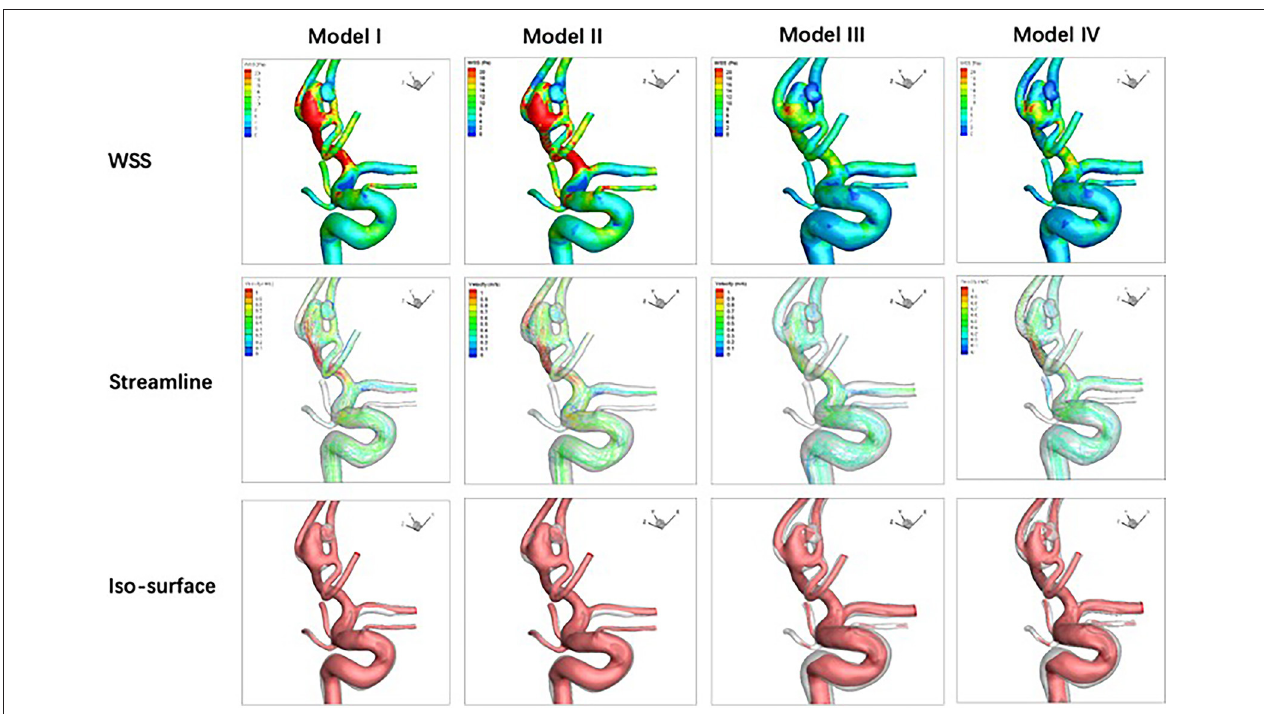
FIGURE 5 | Hemodynamic characteristics of four models are illustrated in LVIS stenting for an anterior communicating artery aneurysm with a daughter sac. Compared with Model I, wall shear stress increases, and velocity decreases while the high flow volume does not change significantly in Model II. Wall shear stress, velocity, and high flow volume in Models III and IV decreased significantly compared with Model